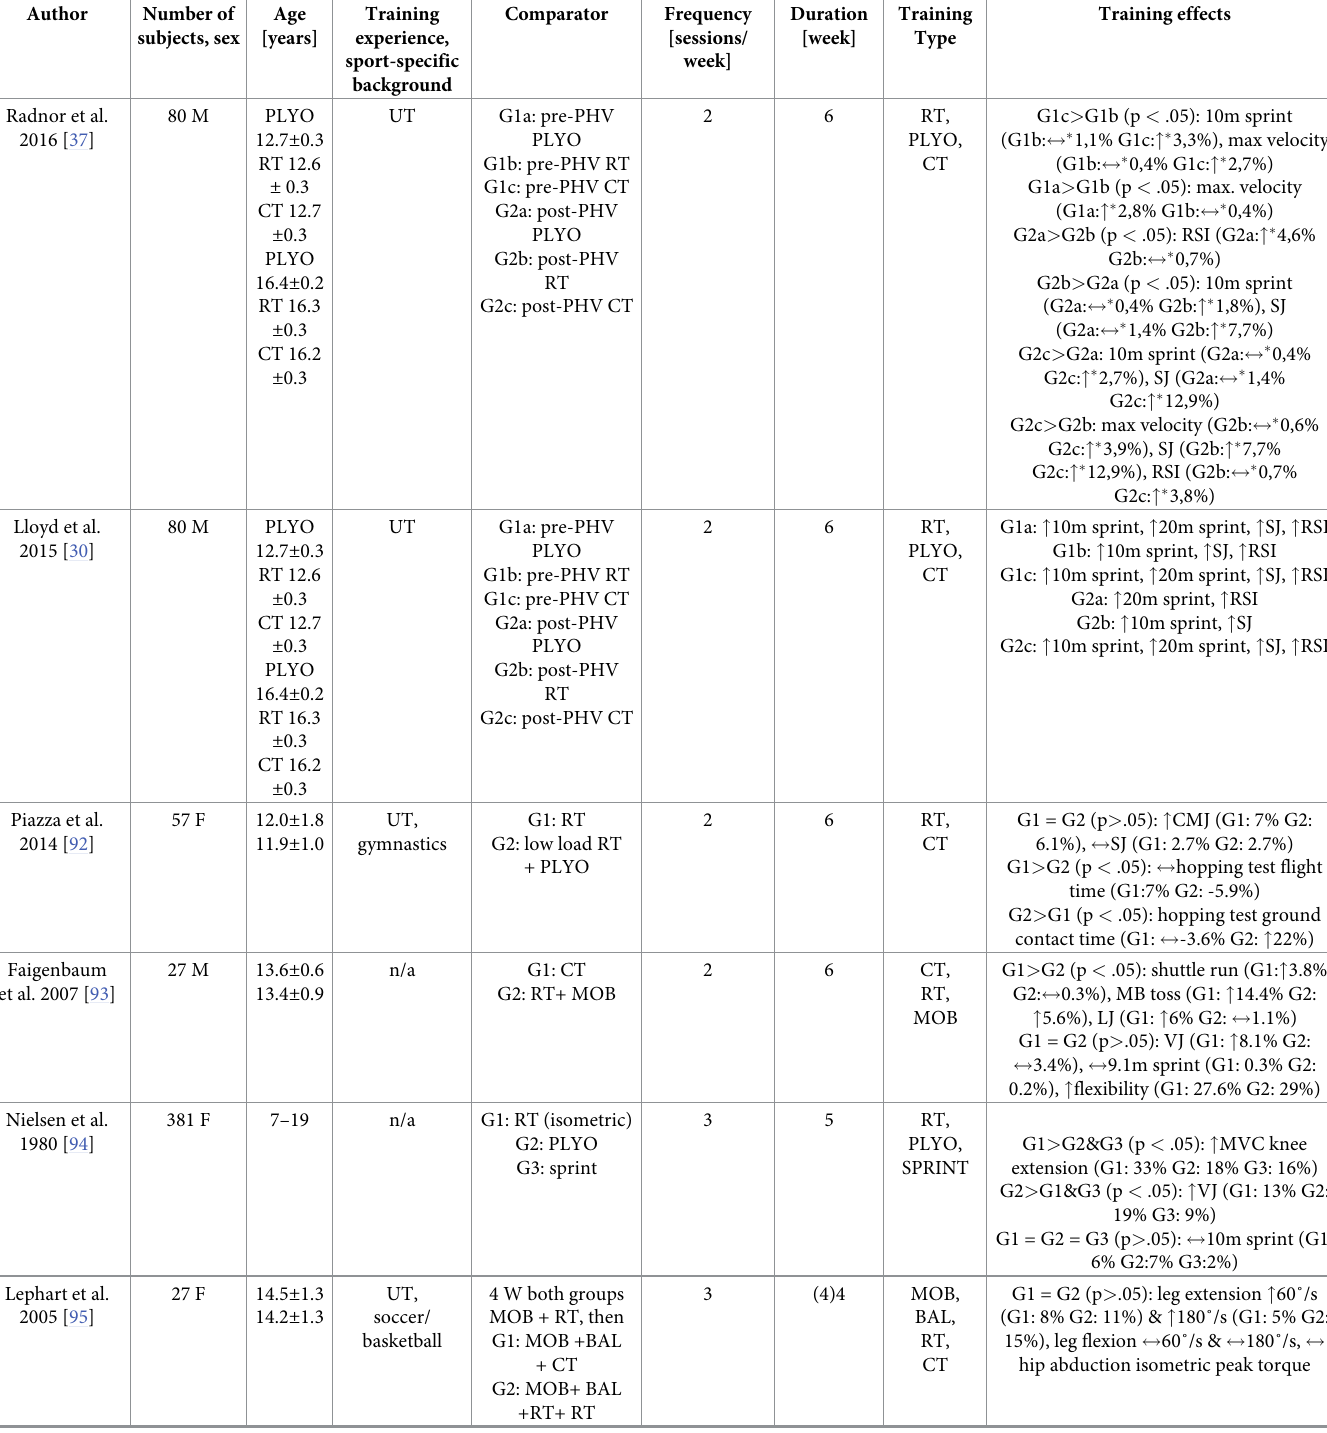
Table 12. Influence of the moderating variable ‘training type’ on training induced improvements in components of physical